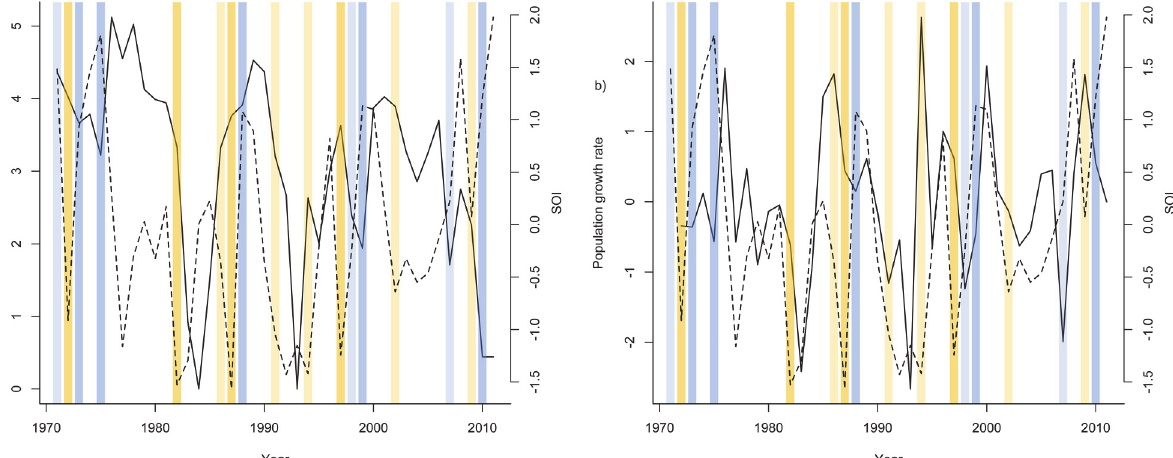
Fig 3. Temporal trends in a) log abundance (solid line) and southern oscillation index (SOI) (dashed line) and b) population growth rate (solid line) with SOI (dashed line) on BCI over the last 40 years. Yellow shaded bars show strong (darker shading) and moderate (lighter shading) el nino events and blue bars show strong (darker shading) and moderate (lighter shading) la nina events (see http://ggweather.com/enso/oni.htm for description of strength